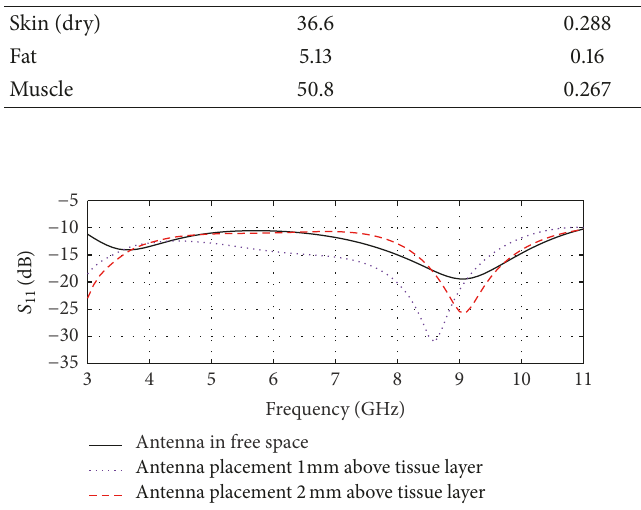
Figure 13: PM antenna return loss characteristics on dispersive phantom